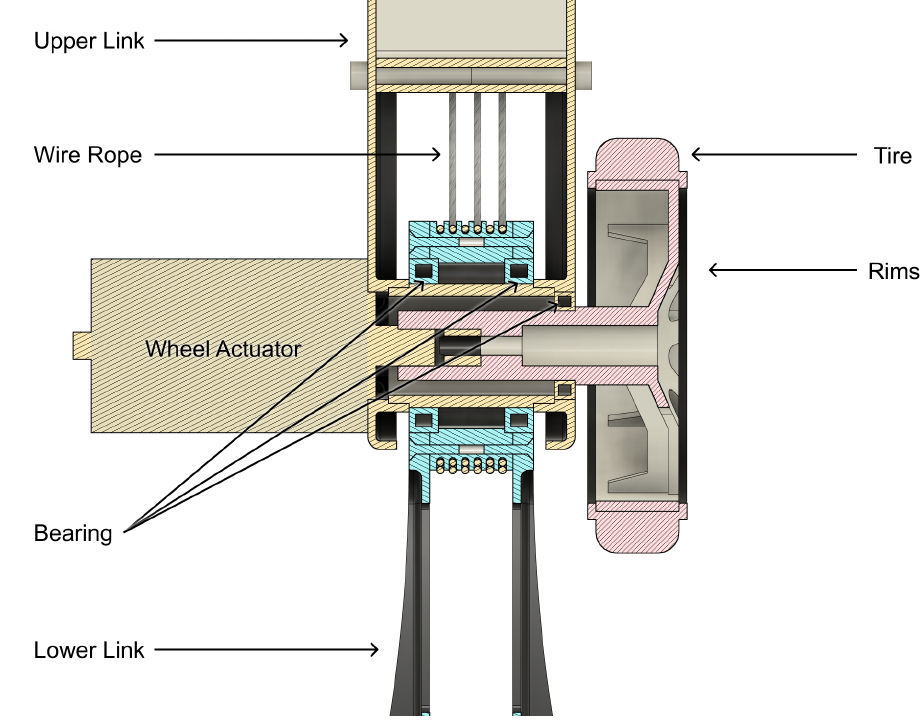
Figure 4. The designed structure of the robot knee.